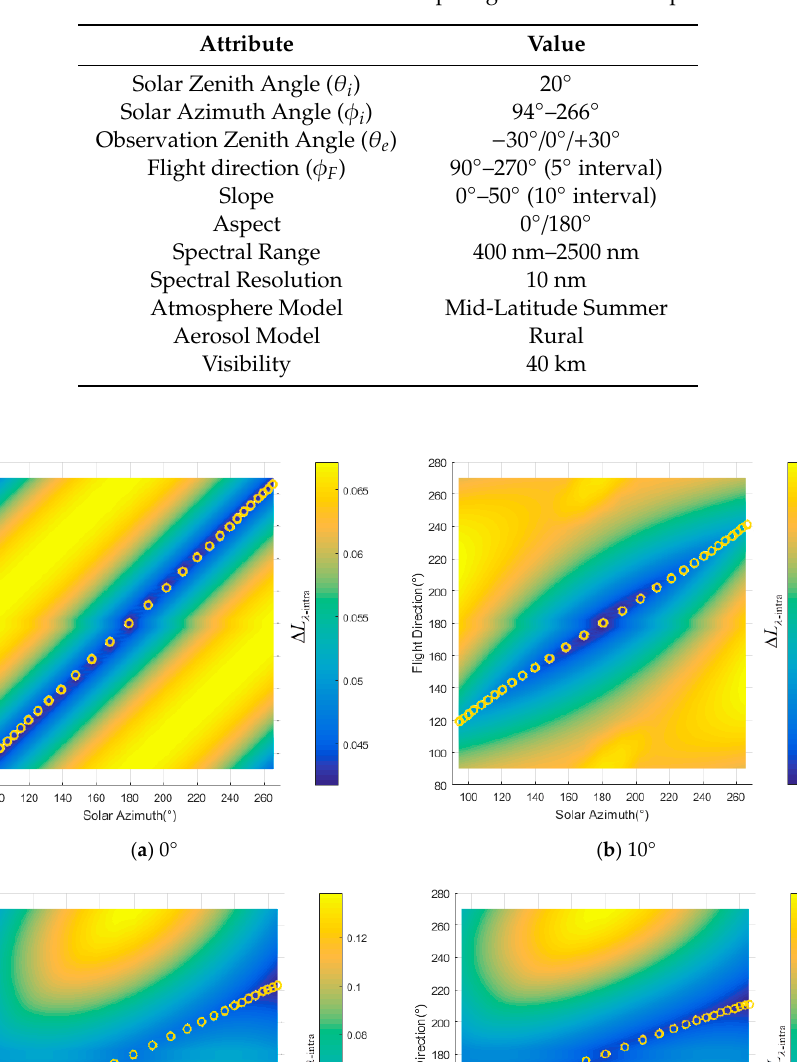
Table 2. Simulation Parameters for solo slope digital simulation